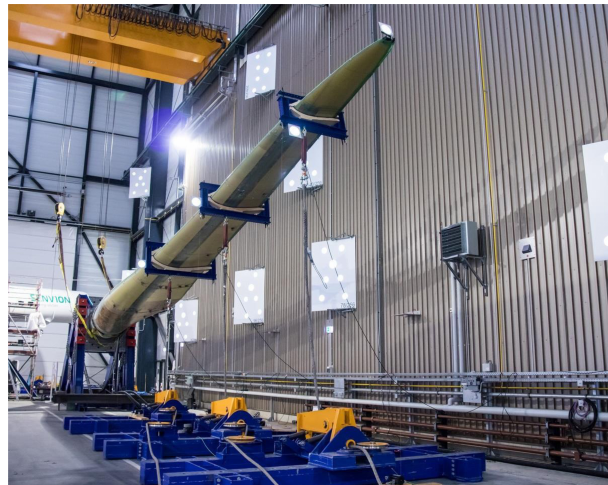
Free–free boundary conditions were applied after the blade manufacturing by means of elastic suspensions con- nected to lifting straps. The blade was excited using an im- pact hammer with soft tip at a total of eight excitation points.